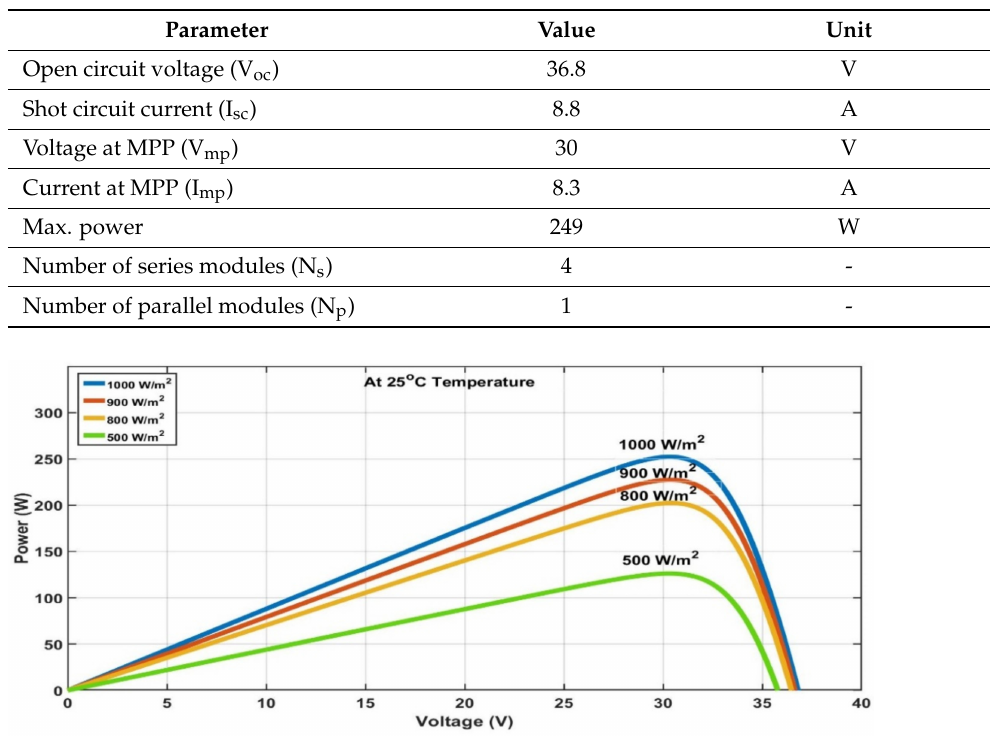
Table 1. Specifications of solar module.